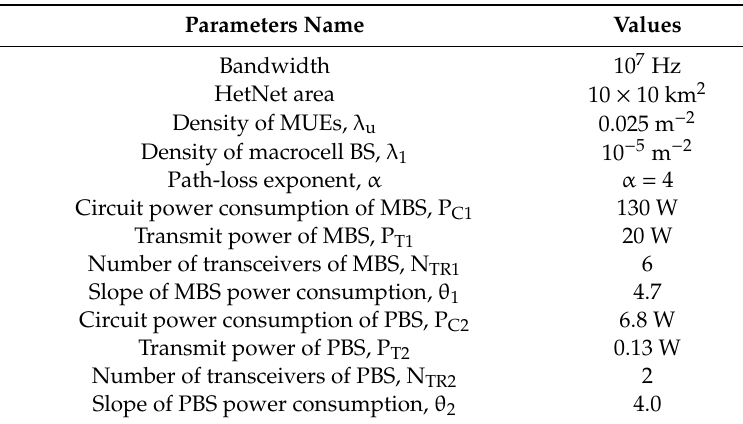
Table 1. Simulation parameters.